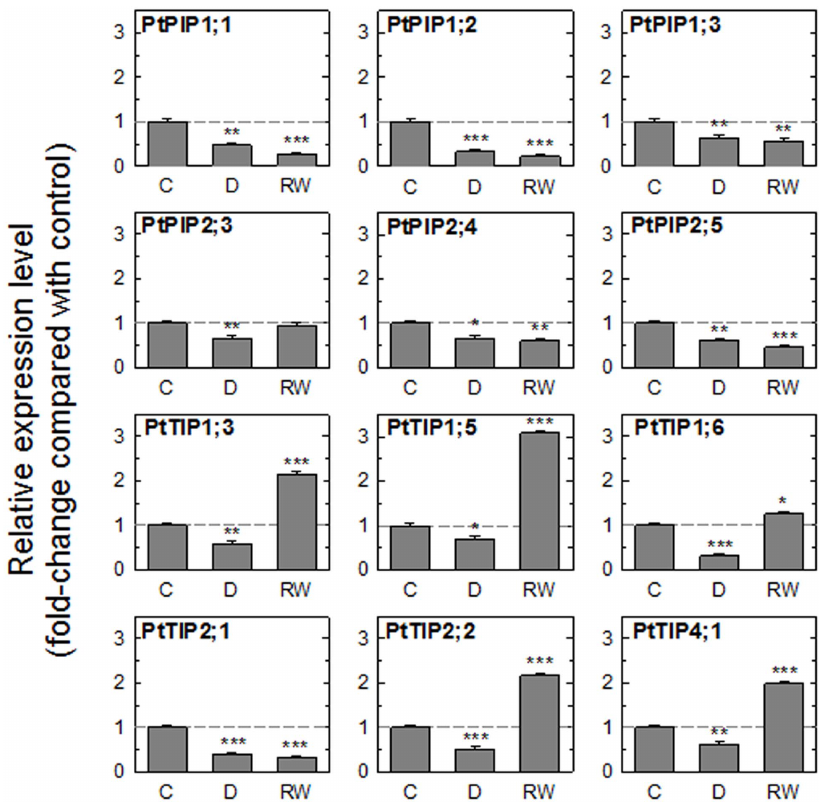
Figure 2. Relative expression of aquaporin genes in leaves of plants exposed to a drying-rewatering cycle. Gene expression was measured in leaves of well-watered control plants (C), drought-stressed plants (D), and 3 h after drought-stressed plants were rewatered (RW). The geometric mean of the expression levels of four reference genes ( ACT2 , CYC063 , TIP41-like , UBQ7 ) was used to normalize the results. Asterisks denote significant differences in expression level compared to control levels (one-way ANOVA, followed by Bonferroni’s post test, * P # 0.05; ** P # 0.01*** P # 0.001). Data are means 6 SE of three biological replicates. doi:10.1371/journal.pone.0111751.g002 PLOS ONE |